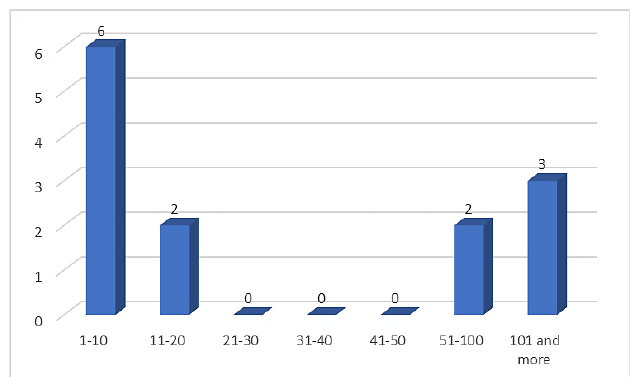
Fig. 5. Number of implemented projects in the surveyed companies using agile development methods.